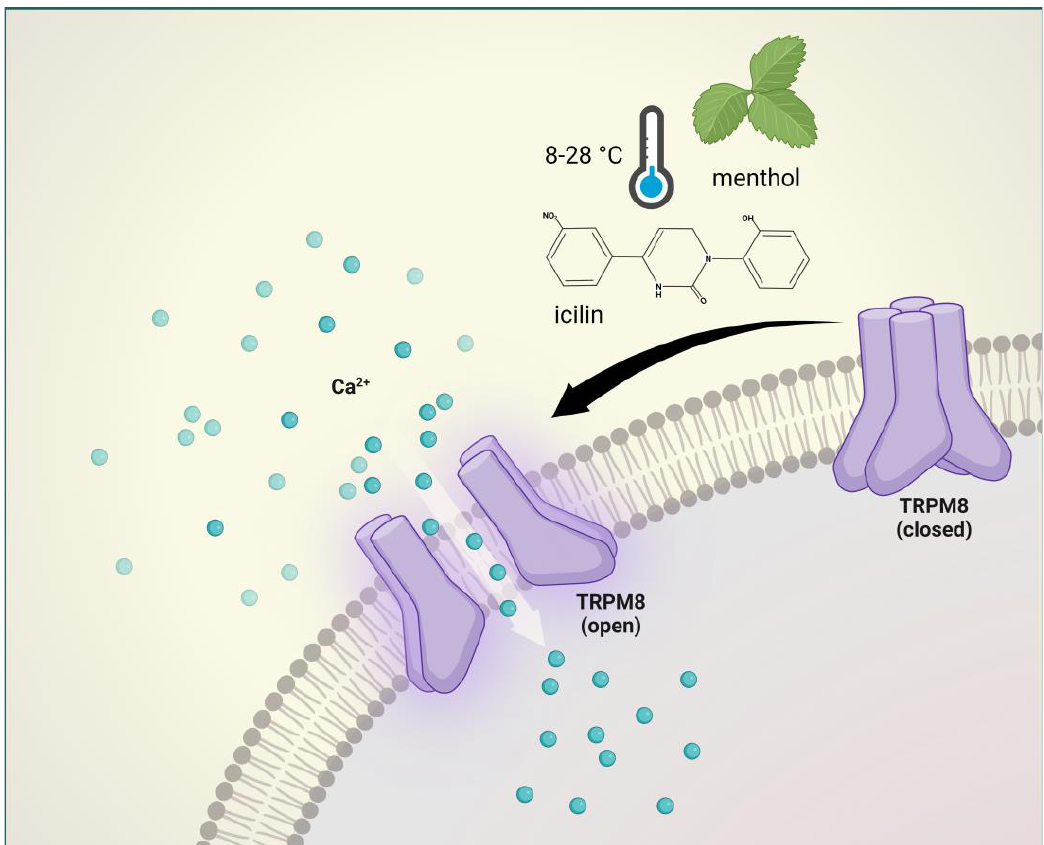
Figure 5. Transient receptor potential melastatin 8 receptor activation. The TRPM8 is activated by cold temperatures (8 – 28 °C), membrane depolarization, menthol, and icilin. TRPM8 mediates normal thermosensation and has a role in both cooling-mediated analgesia and cold hypersensitivity.